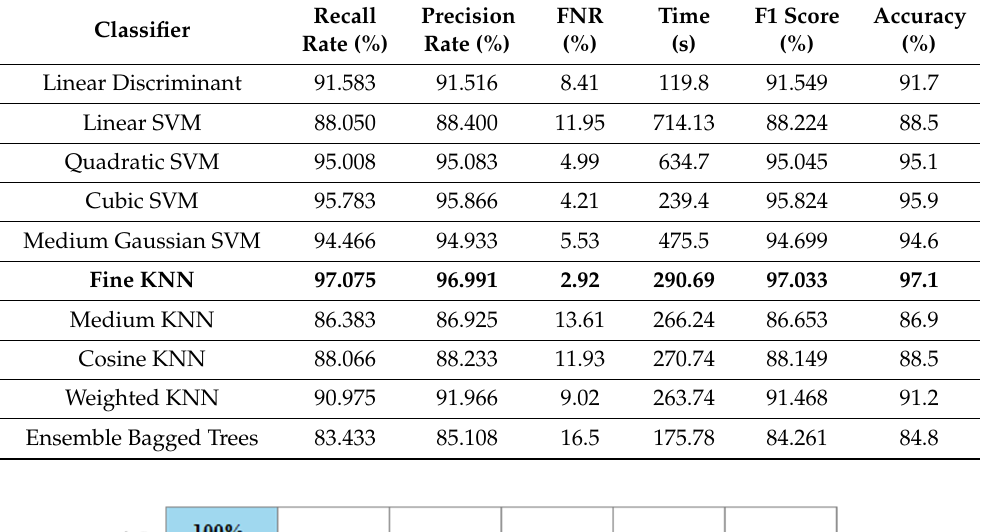
Table 7. Achieved results on KTH dataset after best feature selection using KcWKNN. The bold Table 10. Achieved results on IXMAS dataset after best feature selection using KcWKNN. The bold represents the best obtained values. represents the best obtained values.